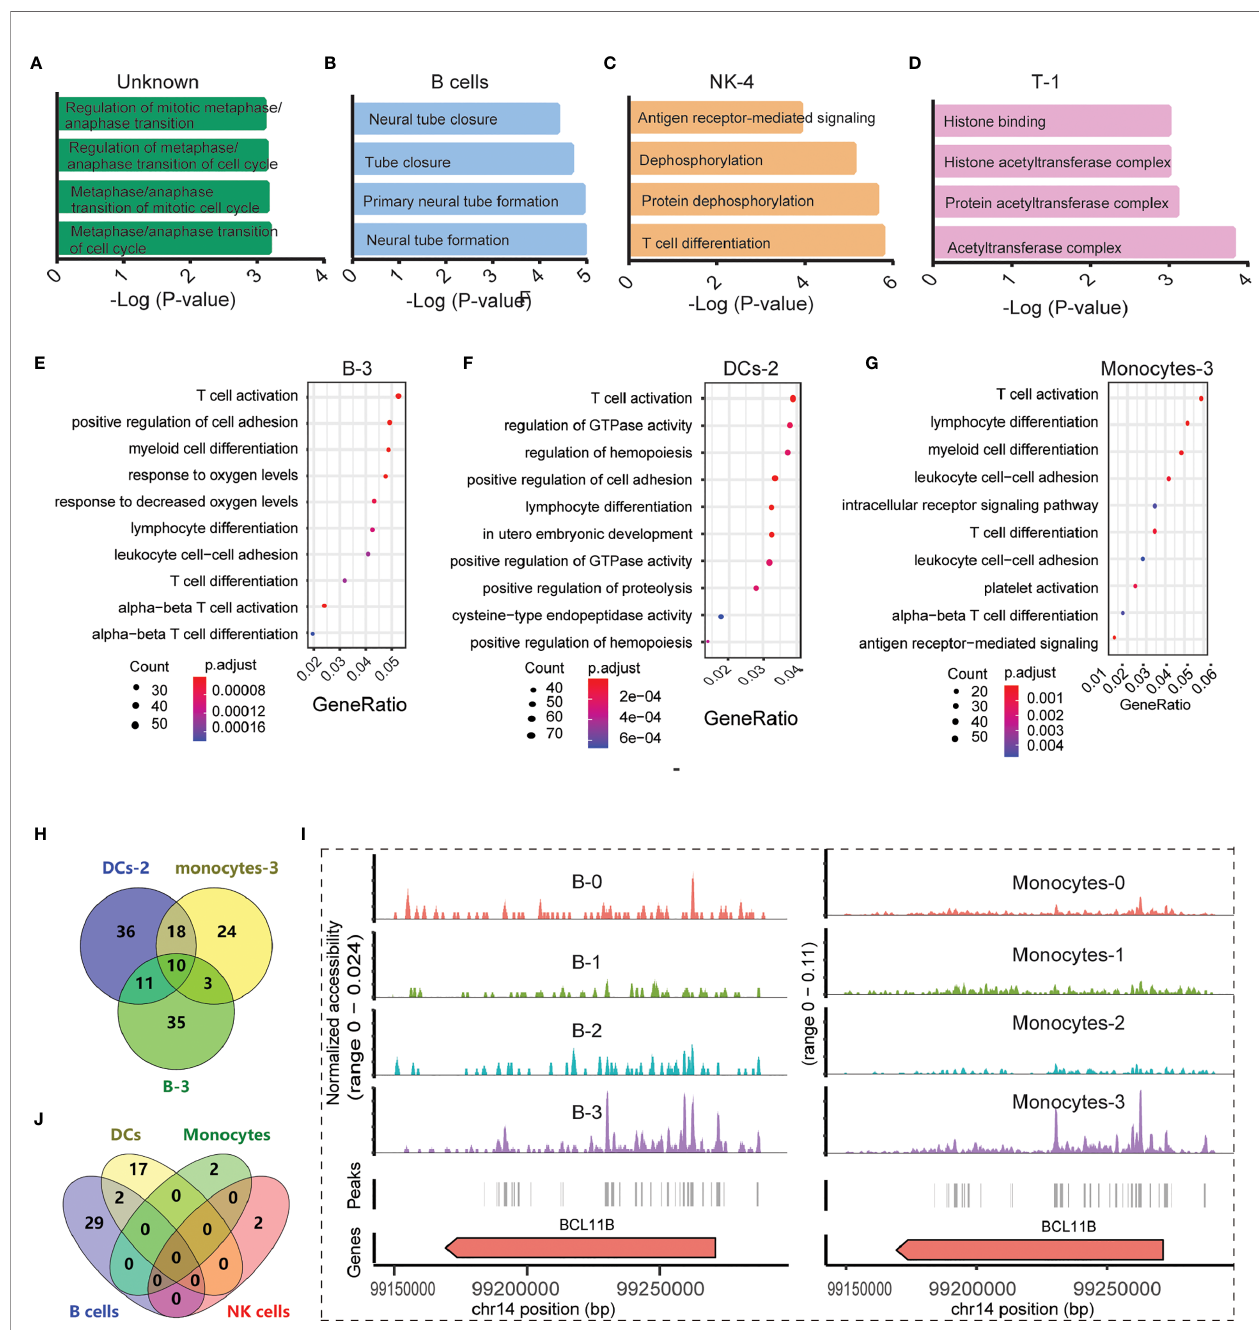
FIGURE 3 | Functional analysis of signi fi cantly differential peaks between the SLE_PBMC and NC_PBMC libraries (p <0.05). (A) GO analysis of 16 differential genes between the SLE_PBMC and NC_PBMC libraries in the unknown group; (B) GO analysis of 447 differential genes between the SLE_PBMC and NC_PBMC libraries in B cells; (C) GO analysis of 917 differential genes between the SLE_PBMC and NC_PBMC libraries in subcluster 4 of NK cells (NK-4); (D) GO analysis of 11 differential genes between the SLE_PBMC and NC_PBMC libraries in subcluster 1 of T cells (T-1); (E) GO analysis revealing the 10 most signi fi cant pathways in subcluster 3 of B cells (B-3); (F) GO analysis revealing the 10 most signi fi cant pathways in subcluster 2 of DCs (DC-2); (G) GO analysis revealing the 10 most signi fi cant pathways in subcluster 3 of monocytes (Monocyte-3); (H) Venn-diagram showing distribution of genes corresponding to T cell activation in (E – G) ; (I) Example locus near BCL11B with differential accessibility across B cell subclusters and monocyte subpopulations; (J) Venn diagram showing the distribution of 52 observed enriched TF motifs between the SLE_PBMC and NC_PBMC libraries. GO, Gene Ontology; SLE_PBMC, PBMCs from patients with systemic lupus erythematosus (SLE); NC_PBMC, PBMCs from healthy controls; NK cells, natural killer cells; DCs, dendritic cells; TF, transcription factor. The p-values were calculated with Loupe Cell Browser 3.1.1 through the difference analysis feature and adjusted using the Benjamini – Hochberg correction for multiple